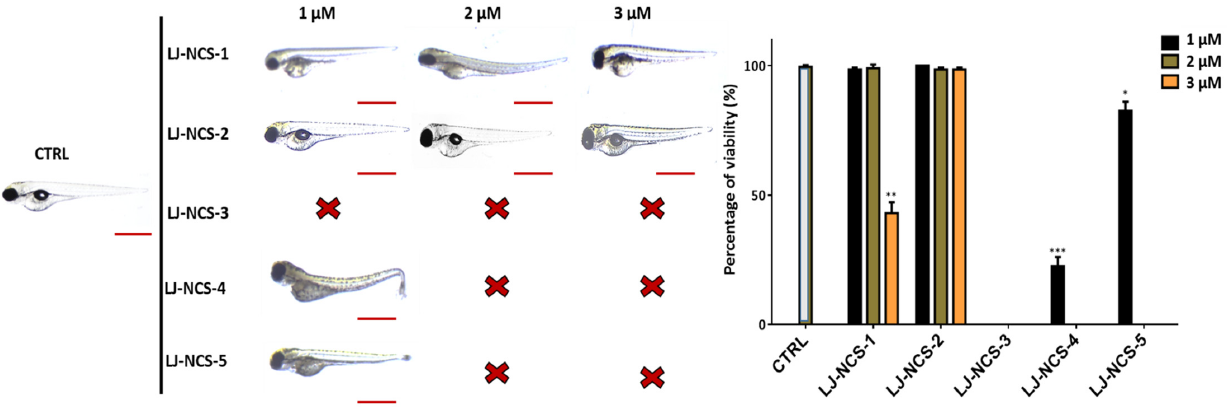
Figure 9. The effects of 48 h isothiocyanates treatment on morphology and mortality of 48 hpf zebrafish embryos at the experiment starting point. Representative images of embryos exposed to 1–3, of LJ-NCS-1–5 (n = 3 replicates, 50 embryos per replicate); bar scale = 950 µm. Percentage of viability-data are represented as mean ± SD; * p < 0.05, ** p < 0.01 and *** p < 0.001.